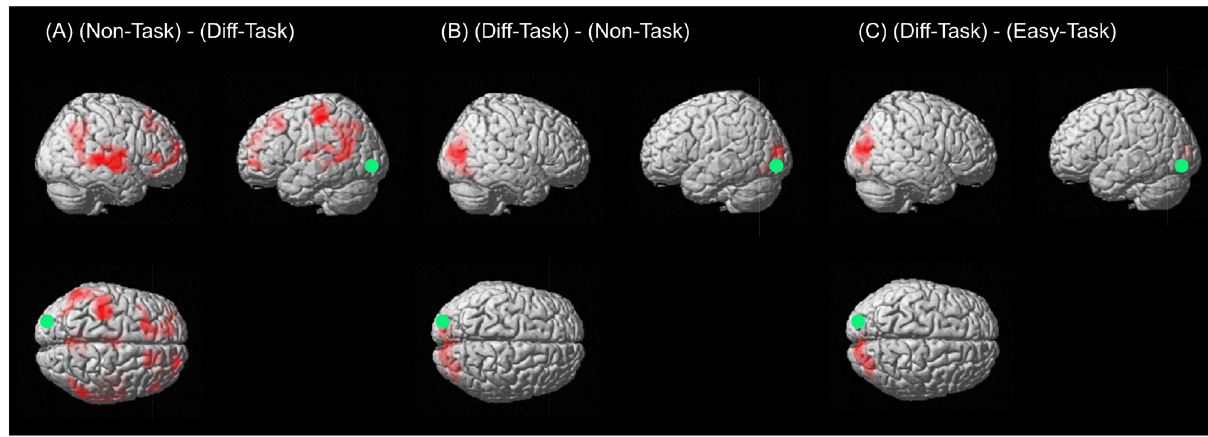
Figure 4. PPI results with right OG as seed (voxel level threshold of p uncorr < 0.001 with cluster level threshold of p FWE − corrected < 0.05 ). ( A ) Areas are more closely related to right OG in Non-Task than in Diff-Task . ( B ) in Diff-Task than in Non-Task and ( C ) in Diff-Task than in Easy-Task . Green circles indicate the seed in each figure but actual size was sphere diameter of 6